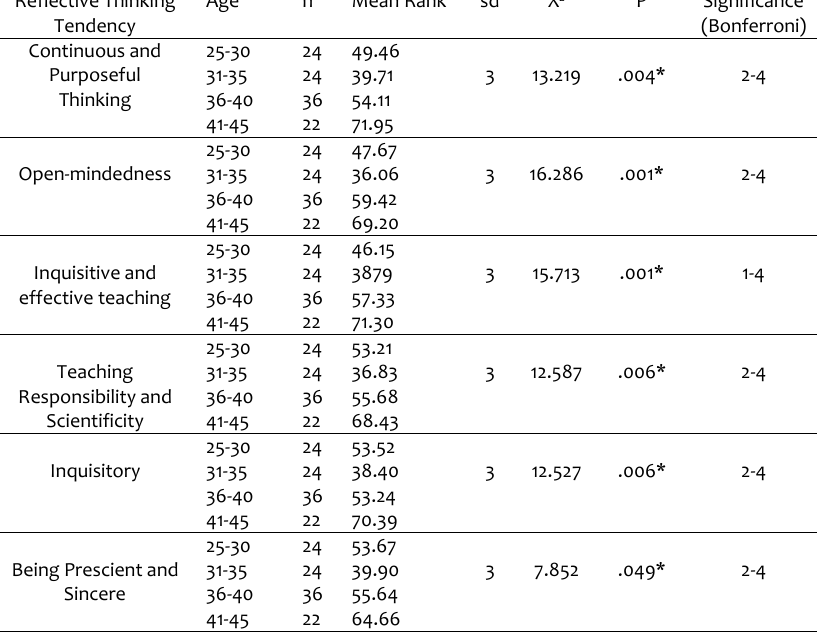
Table 3. Kruskal Wallis H test results associated with the sub-dimensions of the reflective thinking tendency scale according to preschool teachers’